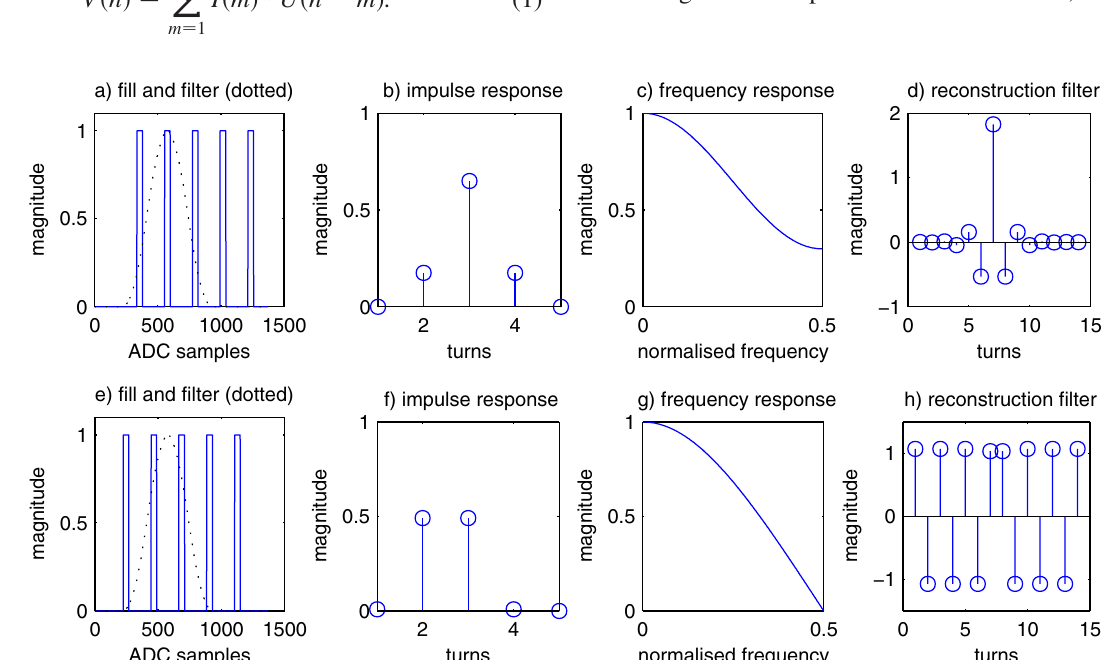
FIG. 7. Filtering effects in the BPMs and their removal using a reconstruction filter: fill pattern well aligned (top) and poorly aligned (bottom). See text for